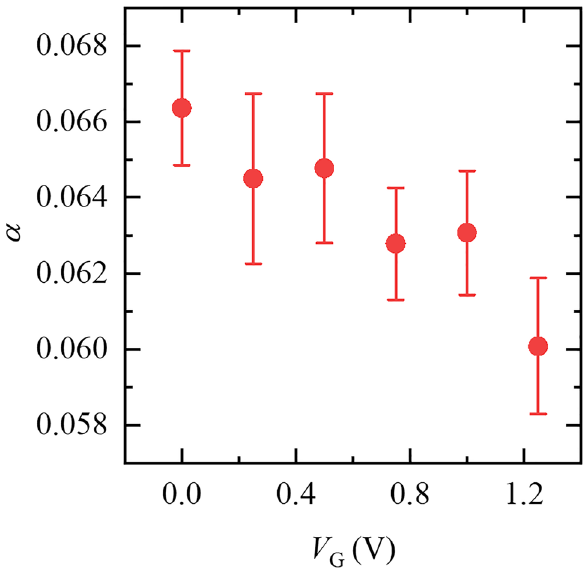
Figure 3. Gate-tunable Gilbert damping parameter, α . Gate voltage dependence of the Gilbert damping parameter, α . As a positive gate voltage is applied, α is decreased due to the suppression of the spin–orbit interaction in the gated